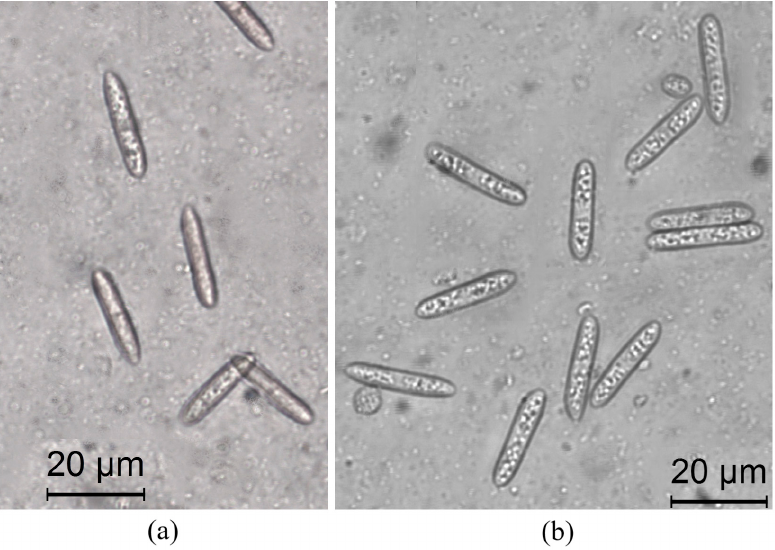
Figure 9. Conidia of C. coccodes isolate C20UgKgPT2 ( a ) and C. nigrum isolate C21KSPeF6 ( b ).